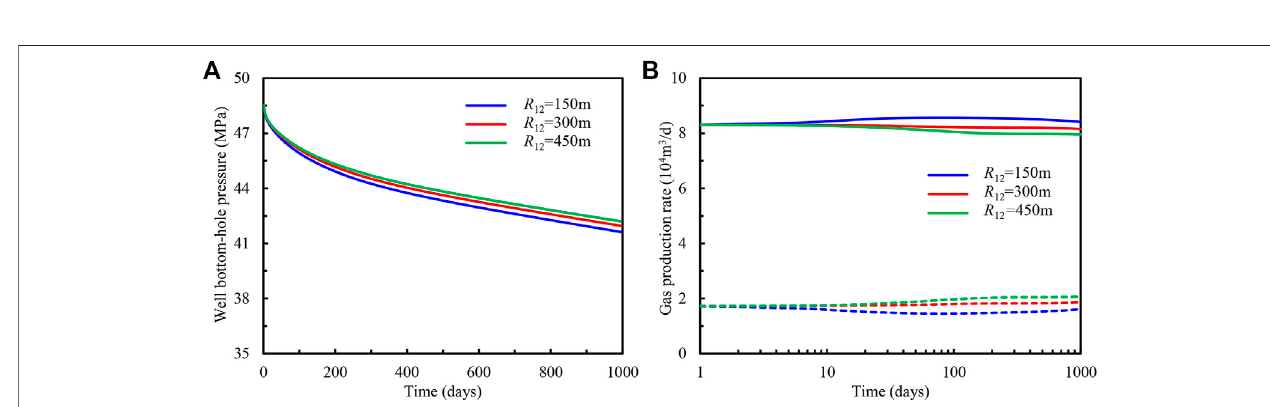
FIGURE 6 | In fl uence of radius for the inner region in the second layer on (A) well bottom-hole fl owing pressure and (B) gas production of individual formation.